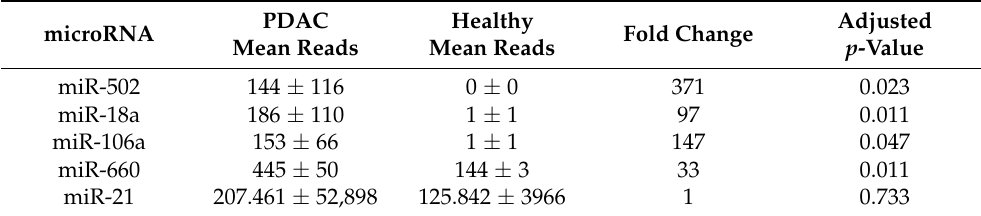
Table 2. miRNAs differentially expressed in small EVs of PDAC versus healthy plasma. Small EVs were isolated from plasma of stage I–IIA PDAC patients and matched healthy subjects (n = 12, mean age 56 ± 5 years for PDAC and 54 ± 6 years for healthy subjects, equally divided by gender, all Caucasian). RNAs were isolated and pooled into 4 individual groups for PDAC and healthy controls, respectively. Small RNA sequencing was performed using the Illumina platform SE50. The sequencing data were aligned using STAR (Spliced Transcripts Alignment to a Reference) 2.5, and analyzed with DESeq2. The fold change was converted from log2 fold values (k) using the y = 2k